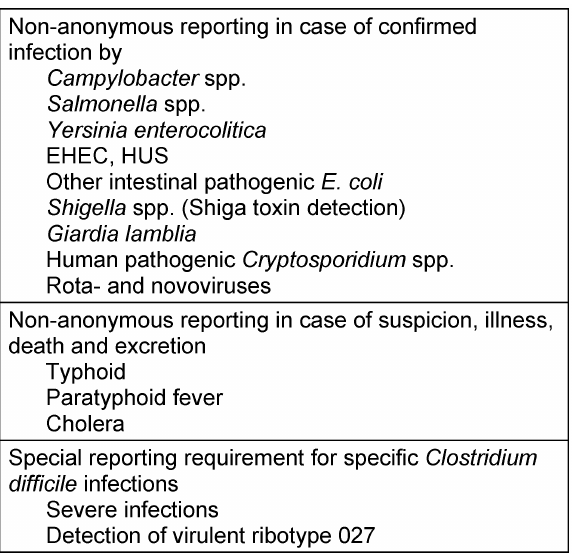
Table 2: Notifiable gastrointestinal